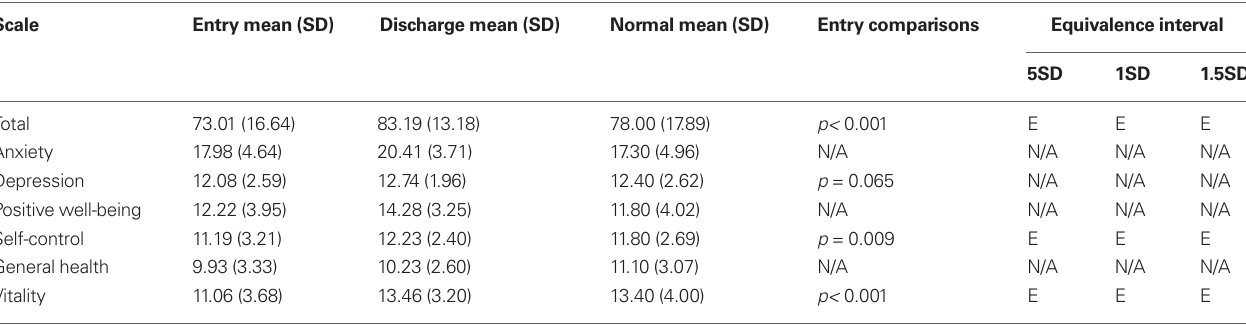
Table 2 | Normative comparisons for all data ( N = 175) for the PGWBI